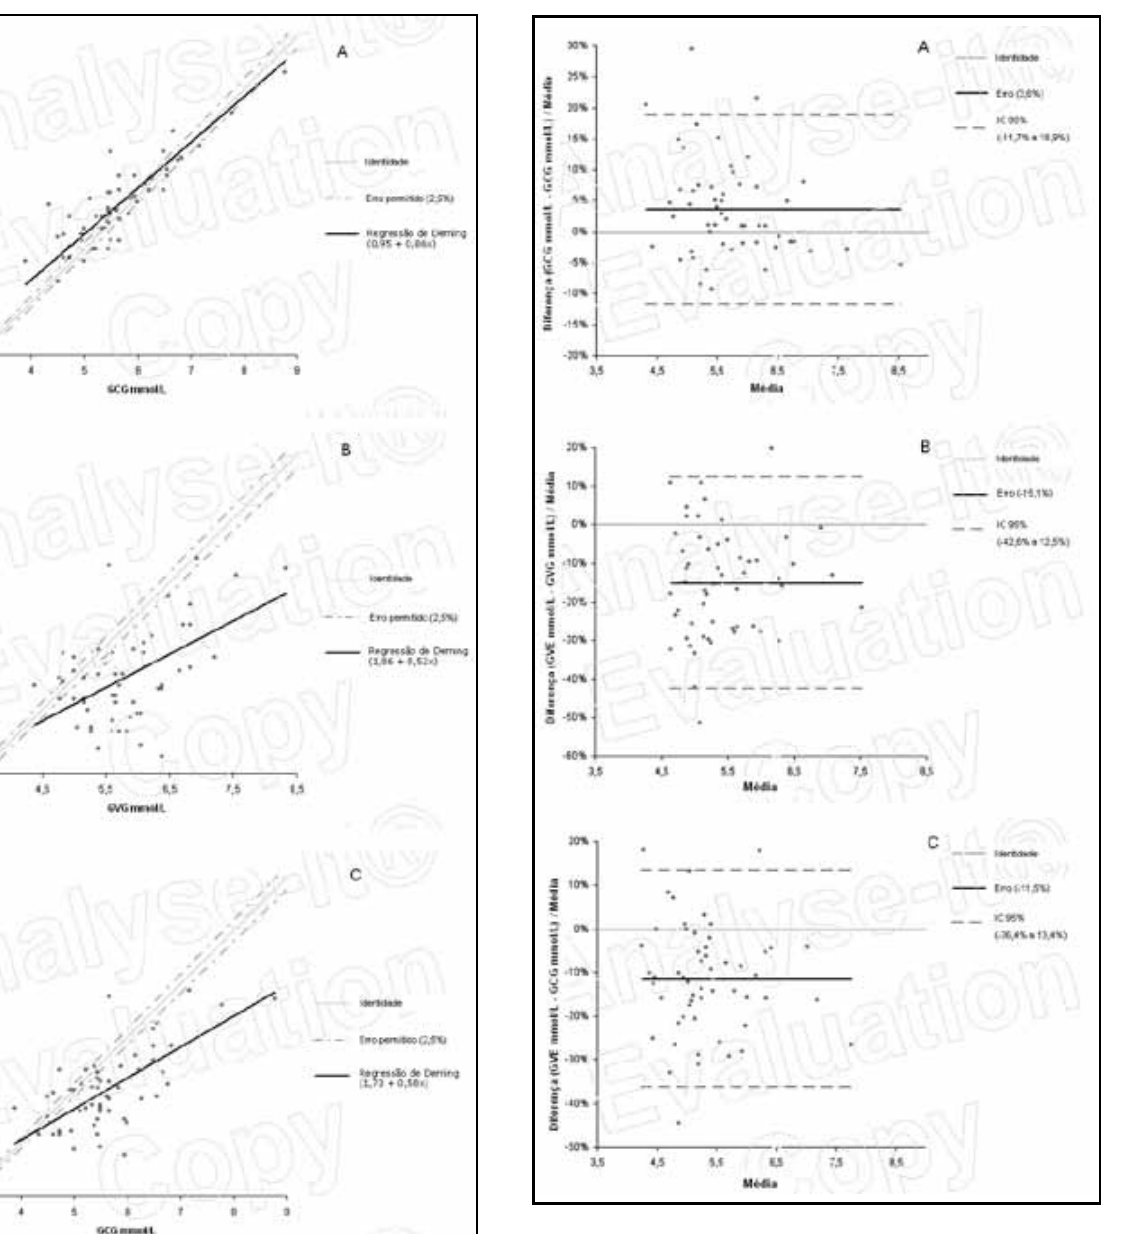
Figura 2 – A: Gráfico das diferenças de Bland-Altman entre os resultados da GCG e da GVG; B: entre a GVG e a GVE: C: entre a GCG e a GVE GCG: glicemia capilar determinada pelo glicosímetro; GVG: glicemia venosa determinada pelo Figura 1 – A: Correlação pela análise de regressão de Deming entre os resultados da